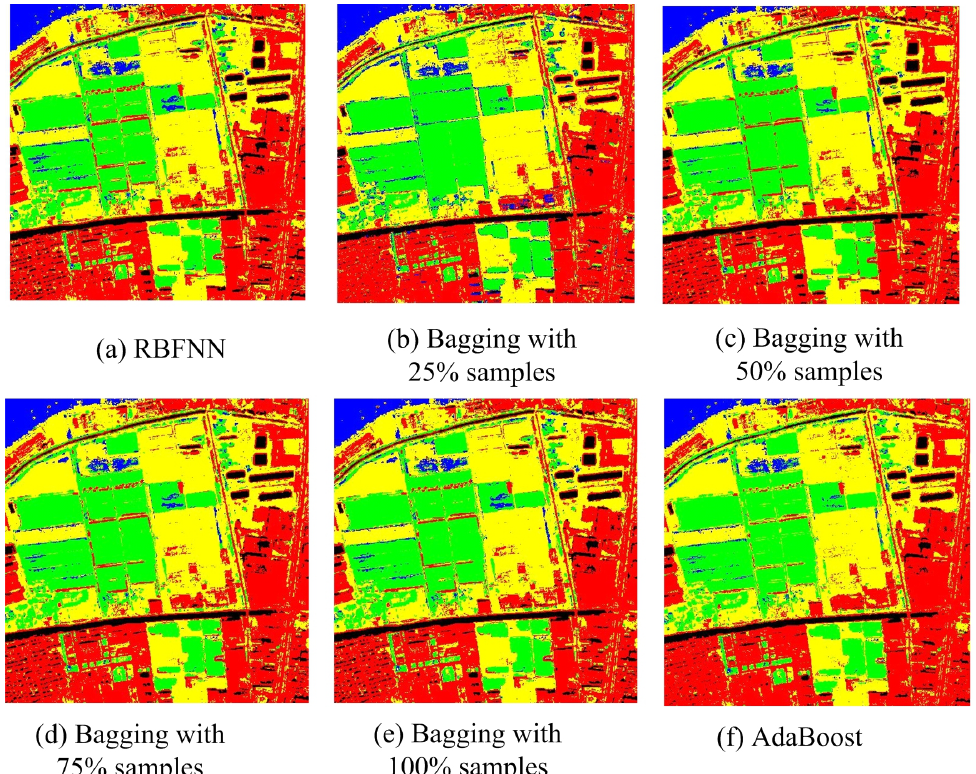
Figure 8. Classifications of RBFNN Based on Bagging and